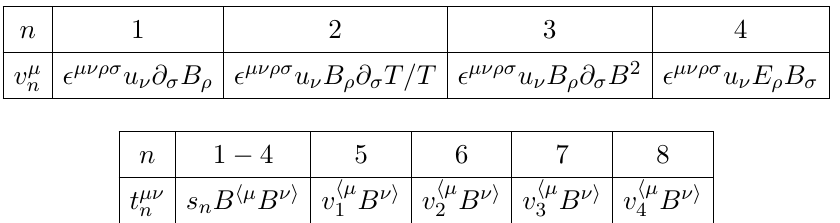
Table 2 . Top: nonzero transverse O ( ∂ ) vectors that appear in the parity-violating equilibrium energy flux Q µ and in the equilibrium spatial current J µ . The vector v µ Bottom: nonzero symmetric transverse traceless O ( ∂ ) tensors that appear in the equilibrium stress T µν . For any two transverse vectors X µ and Y µ , the angular brackets stand for X h µ Y ν i ≡ X µ Y ν + ∆ µν X · Y X ν Y µ − 2 3